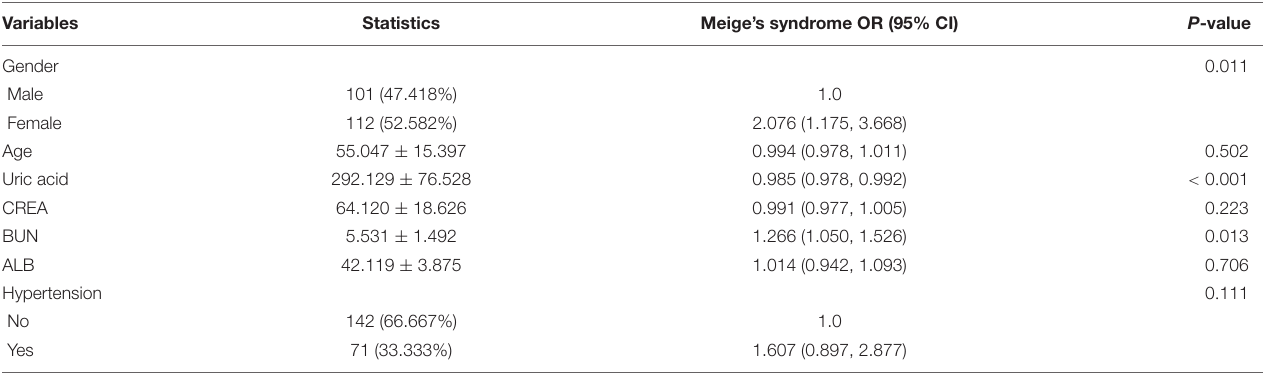
TABLE 2 | Association between each variable and Meige’s syndrome.